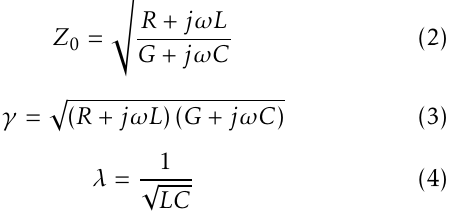
Figure 4. Contribution of each converter voltage, v pantograph harmonic